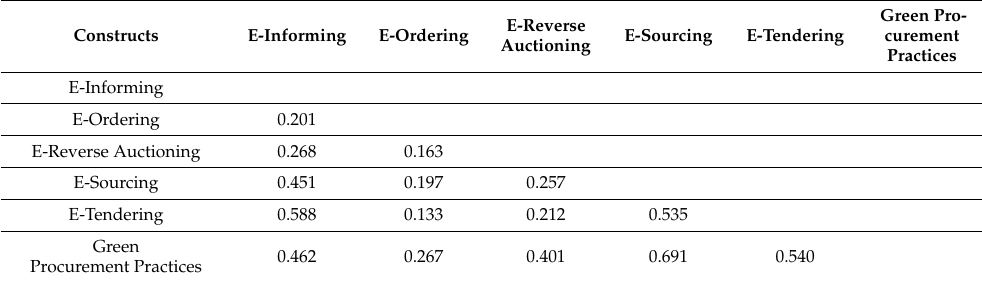
Table 6. Heterotrait–Monotrait (HTMT) ratio.